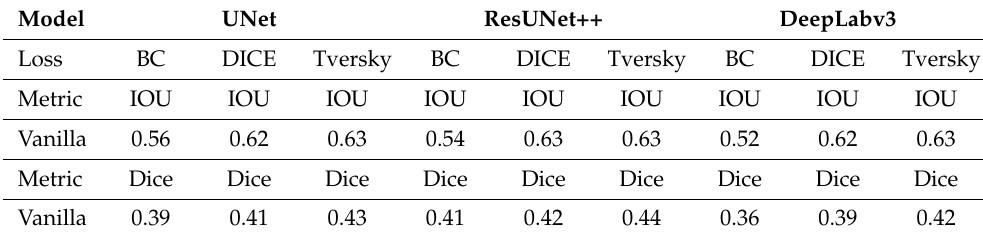
Table 3. The performance according to loss functions in basic X-ray dataset.